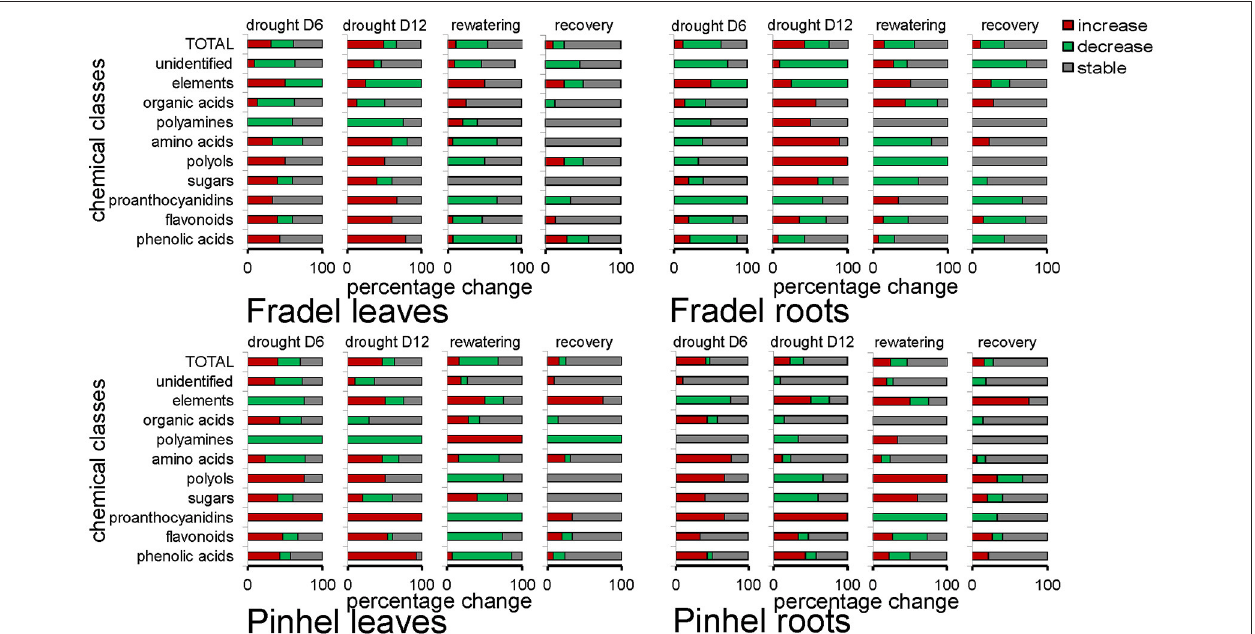
FIGURE 4 | Percentage (0–100% in the x-axis) of metabolites whose levels ( n = 4 to 6) were altered or remained unchanged ( P < 0.05; t -test) after 6 days (drought D6 = stress relative to control) or 12 days (drought D12 = stress relative to control) of drought stress, and following 6 days of rewatering for plants stressed for 6 days (rewatering = rewatered relative to stress; recovery = rewatered relative to control). Metabolites were grouped by biochemical families, with 15 phenolic acids, 17 flavonoids, 3 proanthocyanidins, 5 sugars, 4 polyols, 18 amino acids, 6 polyamines and amino acid derivatives,